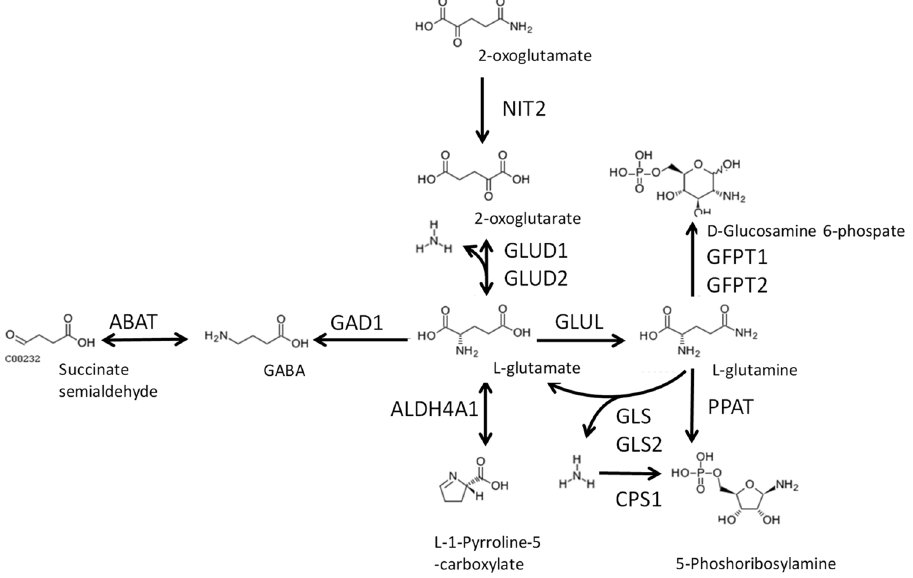
Figure 3. Partial l-glutamate pathway. GLUD1 glutamate dehydrogenase 1, GLUD2 glutamate dehydrogenase 2, NIT2 omega-amidase NIT2, ALDH4A1 aldehyde dehydrogenase 4 family member A1, ABAT 4-aminobutyrate aminotransferase, GFPT1 glutamine-fructose-6-phosphate transaminase 1, GFPT2 glutamine- fructose-6-phosphate transaminase 2, GLUL glutamine synthetase, GLS glutaminase, GLS2 glutaminase 2, PPAT phosphoribosyl pyrophosphate amidotransferase, GAD1 glutamate decarboxylase 1, CPS1 carbamoyl-phosphate synthase 1, GABA gamma-aminobutyric